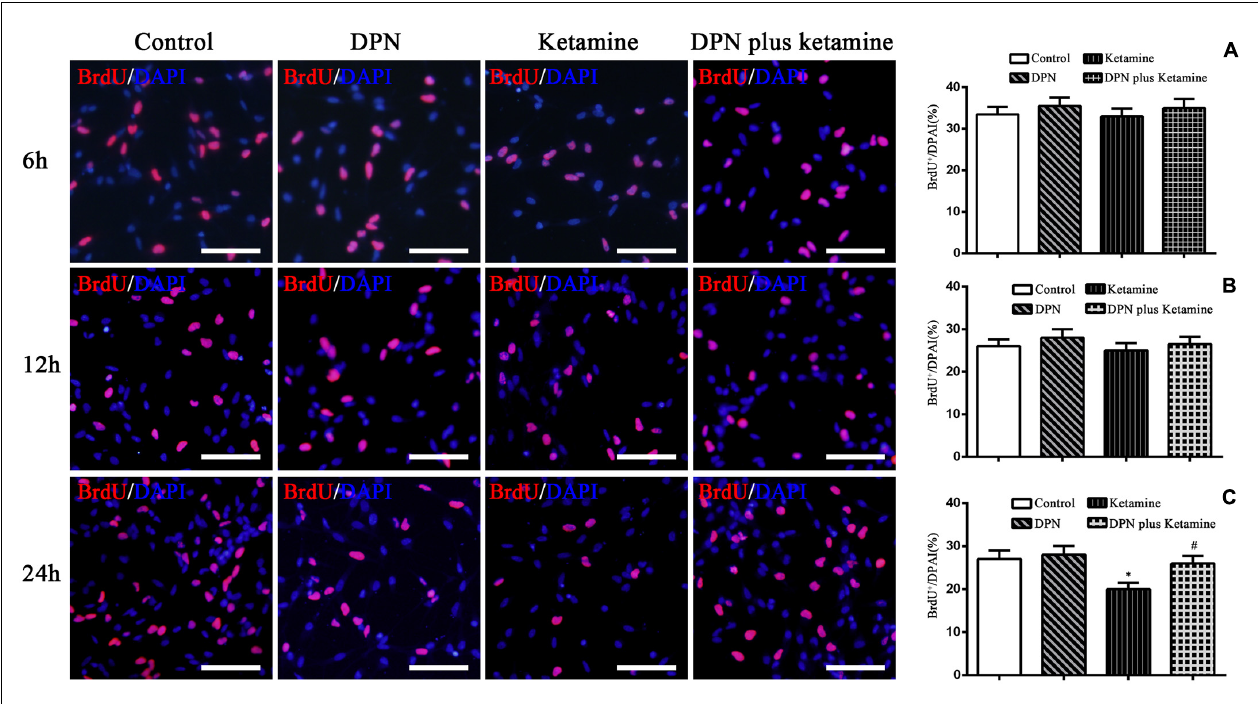
FIGURE 3 | Effect of exposure time on proliferation of NSPCs in different treatment groups. The typical images of BrdU-positive cells (red) in control, DPN, ketamine, and DPN plus ketamine group at 6, 12, and 24 h, respectively. Scale bar = 100 µ m. (A–C) Quantification of BrdU-immunoreactive cells after different treatments at 6, 12, and 24 h, respectively. * P < 0.01 compared with the control group, # P < 0.01 compared with ketamine group. Data were collected from three independent experiments and are presented as means ±